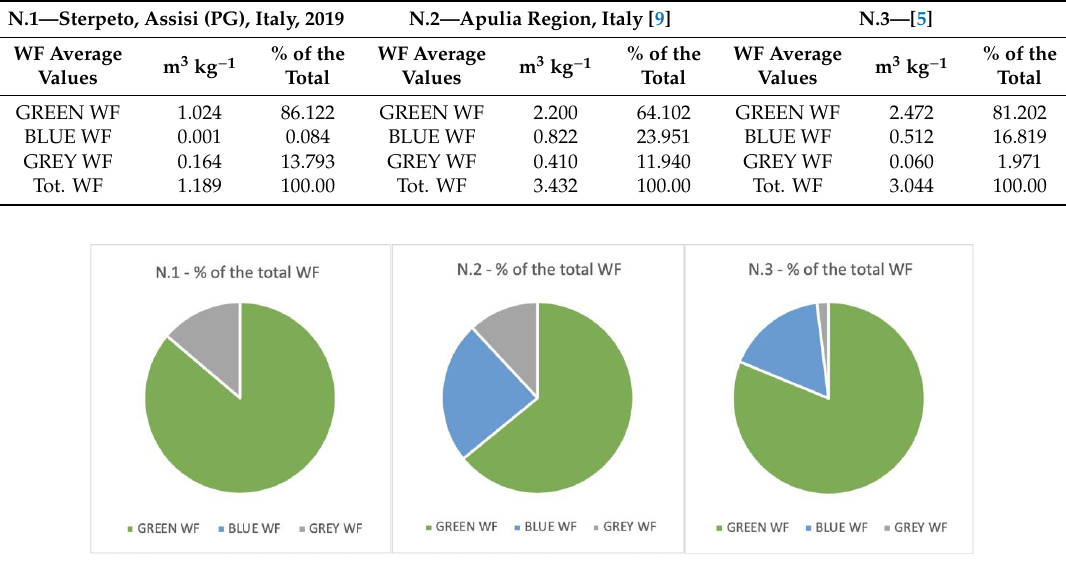
Figure 2. WF types percentages of the total WF in the three compared studies; N.1: Sterpeto, Assisi (PG), Italy, 2019; N.2: Apulia region, Italy [9]; N.3: WaterFootprintNetwork,